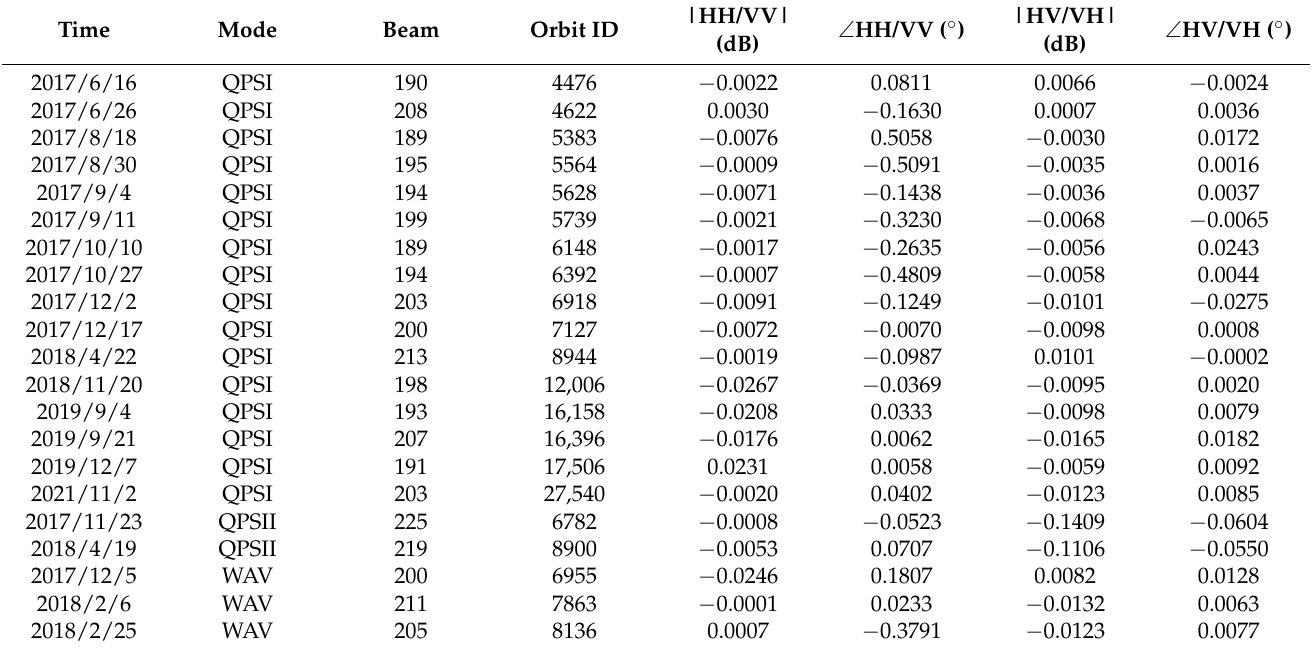
Table 2. The residual distortion error validation of the QPSI, QPSII and WAV modes with the Amazon rainforest datasets, after calibration with the strip estimators. The last four columns represent the residual amplitude and phase of the co-pol channel imbalance, and the cross-pol channel